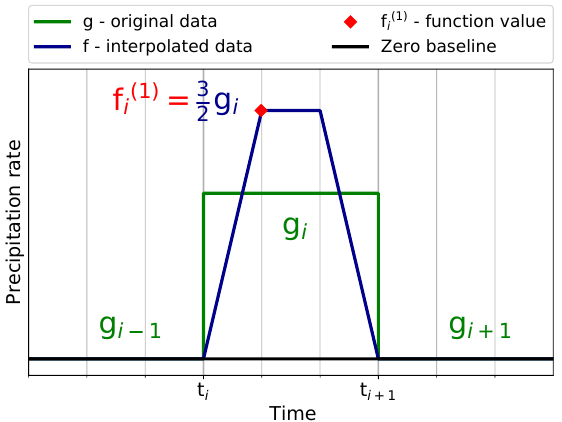
Figure 6. Isolated precipitation event (no precipitation in g i − 1 and g i + 1 ). The only degree of freedom is given by the function value = 3 f ( 1 ) g i and is marked by a red i 2